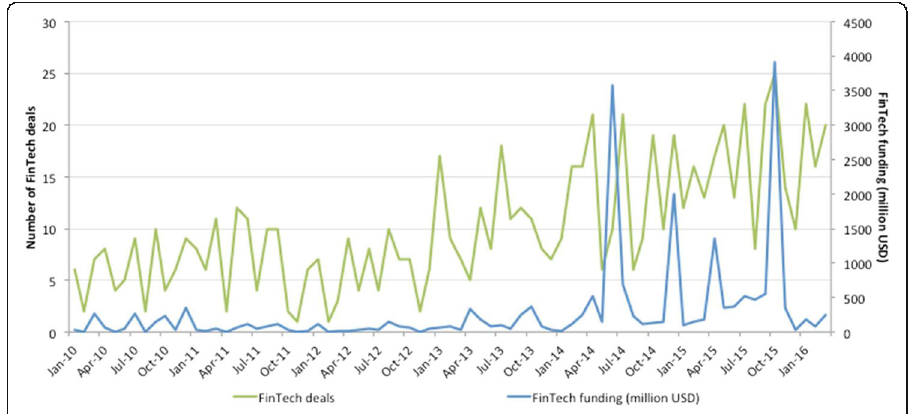
Fig. 1 Evolution of FinTech dollar-volume funding and number of FinTech deals